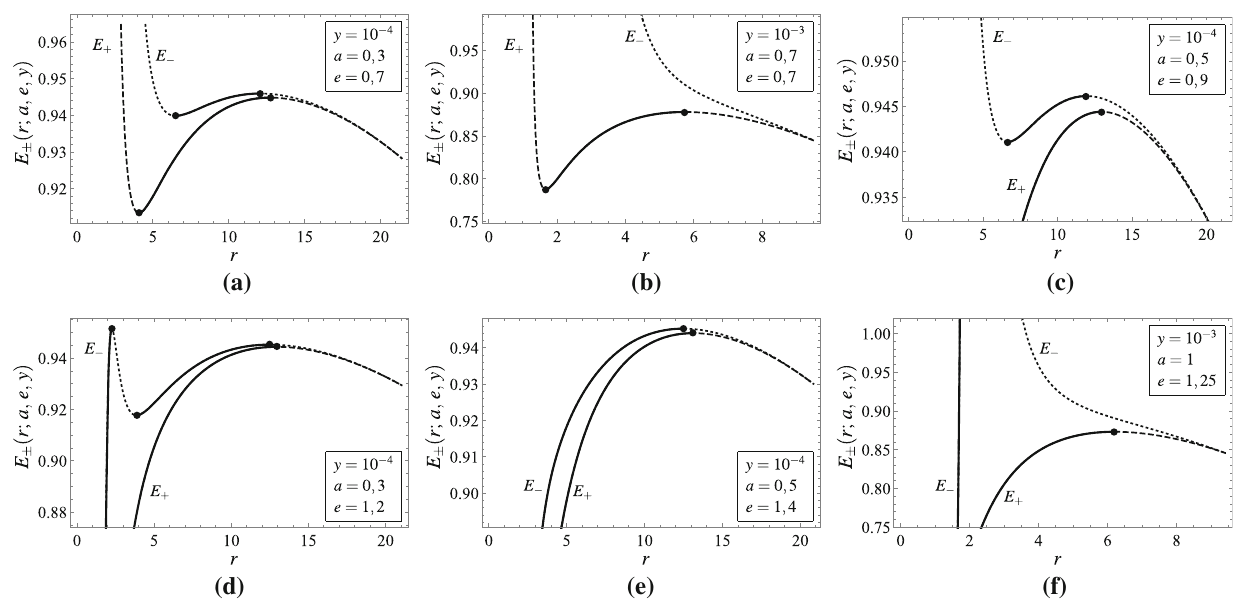
Fig. 8 Characteristic specific energy profiles of test particles on equa- torial circular orbits of the plus/minus-family in the field of KNdS black holes ( a – b ) and naked singularities ( c – f ). Solid parts of the curves cor-